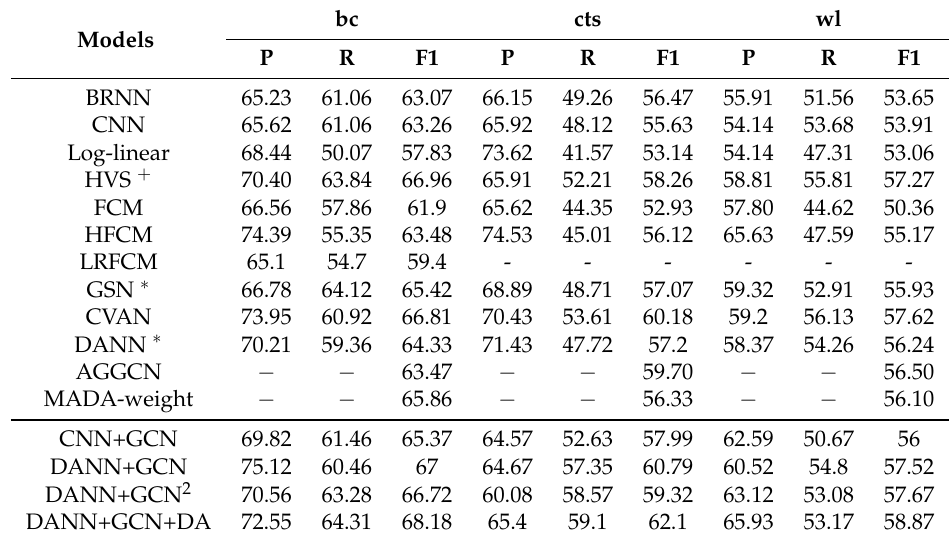
Table 3. Precision (P), recall (R) and macro-F1 (%) comparison with existing methods on three